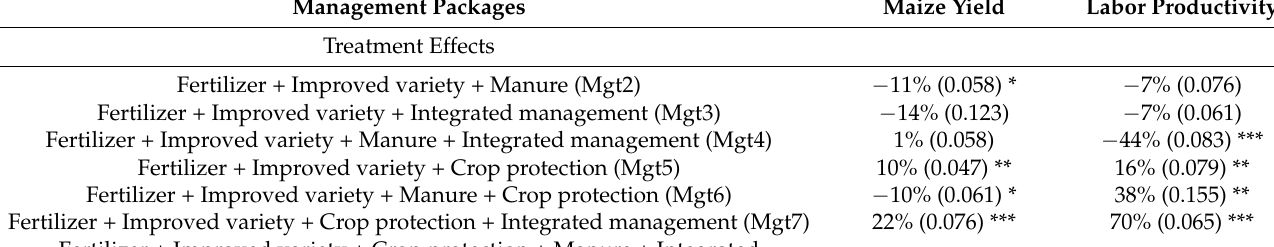
Table 8. METE model results: percentage differences and significance of Mgt2–Mgt8 compared to Mgt1 (Fertilizer + improved variety) for maize yield and labor productivity. Management Packages Maize Yield Labor